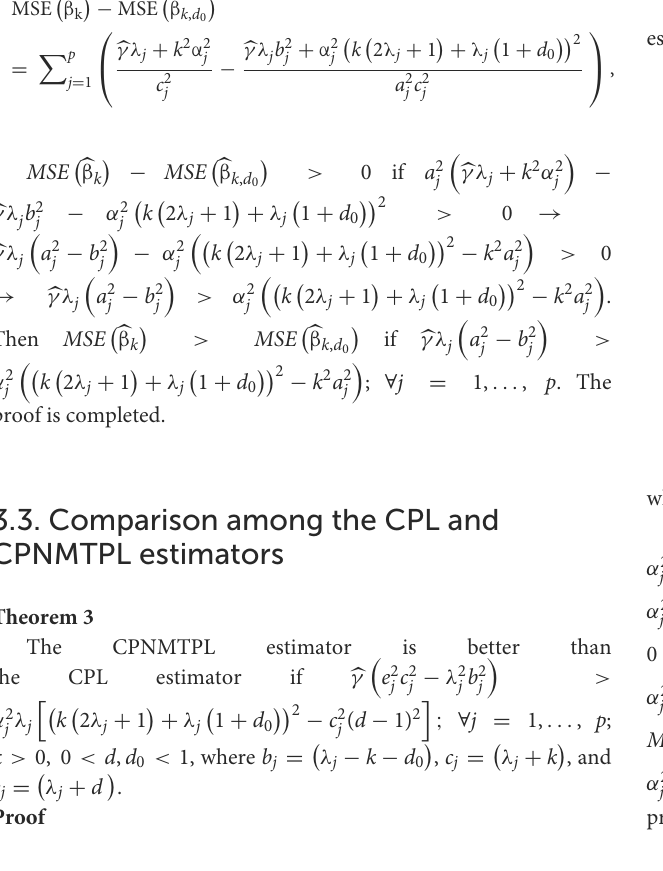
TABLE 5 MSE values in case of p = 6 and γ =